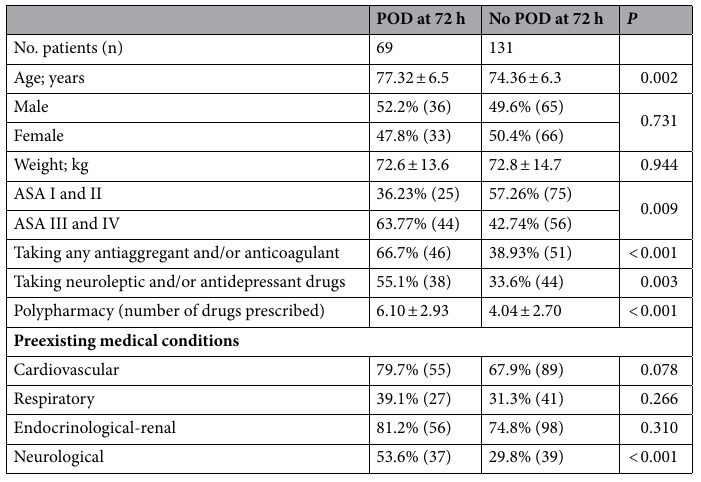
Table 2. Preoperative risk factors for developing postoperative delirium at 72 h. Values are number (%) or mean ± SD. POD indicates postoperative